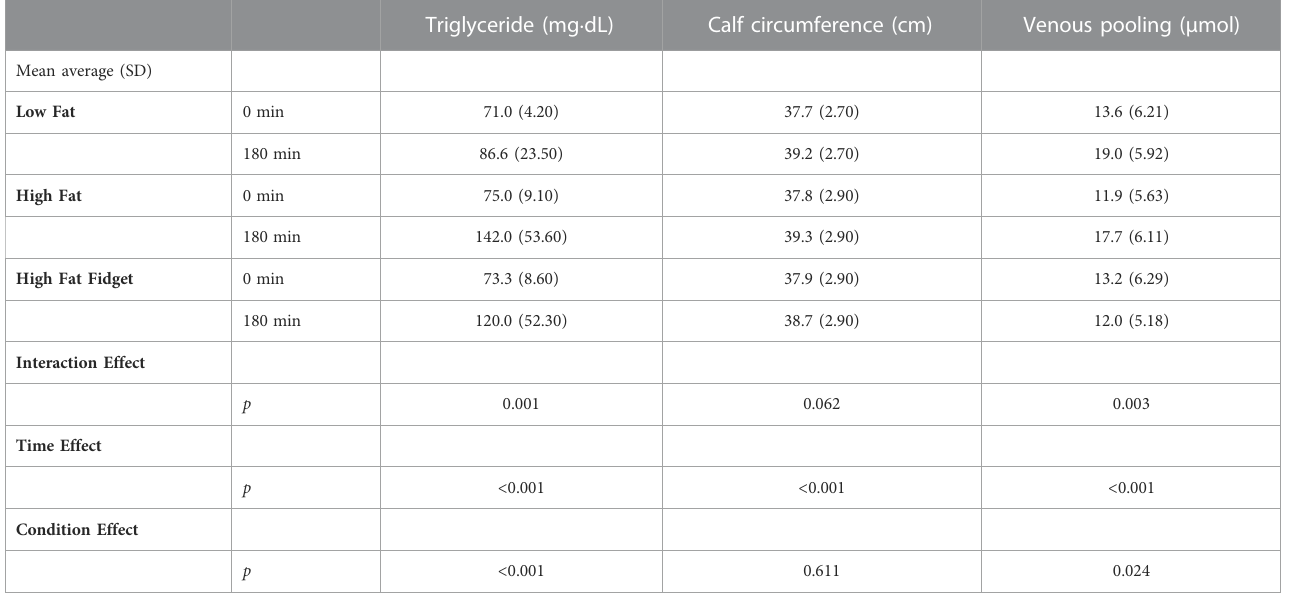
TABLE 3 Mean (±SD) interaction and main effects hemoglobin markers pre and post low fat, high fat and high fat fi dgeting sitting trials (n = 18). Triglyceride (mg · dL) Calf circumference (cm) Venous pooling (µmol)